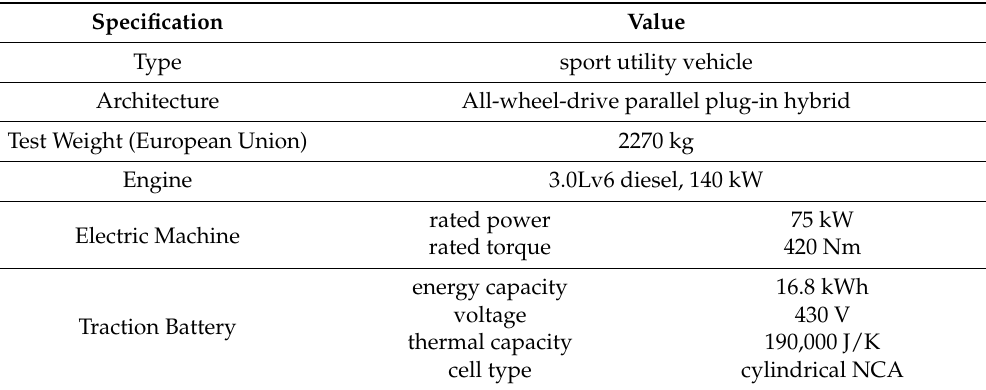
Table 2. Specifications of the target vehicle.